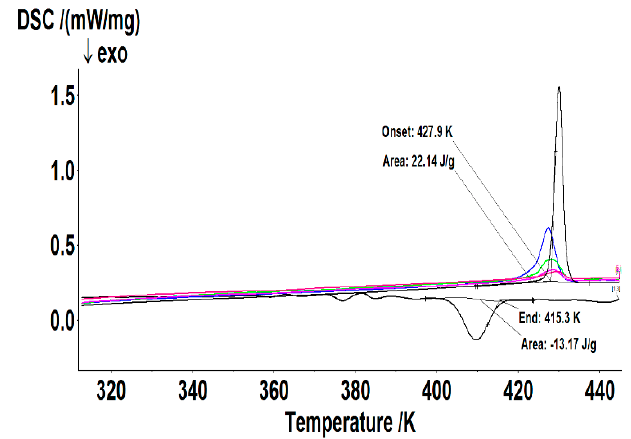
Figure 2. Termal analysis (DSC) of [Fe(HC(pz) 3 ) 2 ](NO 3 ) 2 .